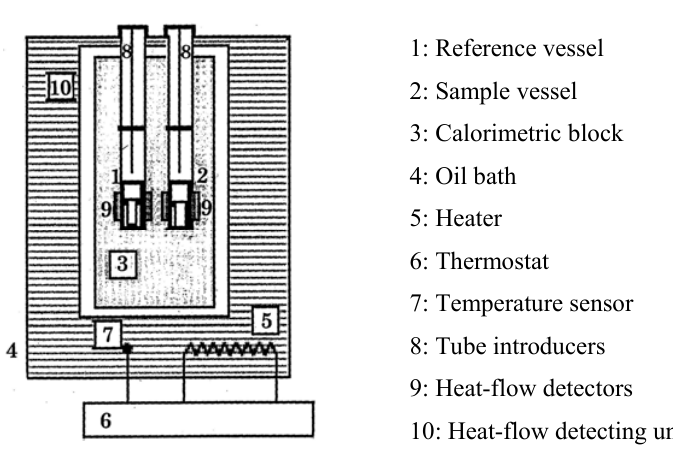
Figure 7. Block diagram of